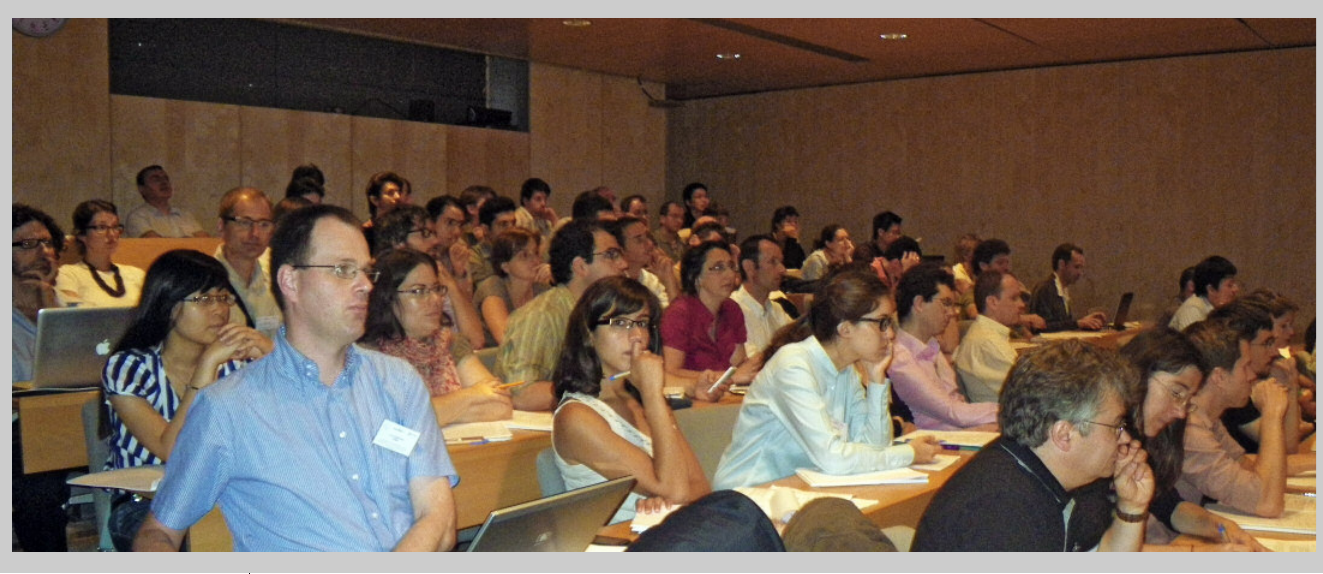
Figure 1: Conference participants at Ecole des